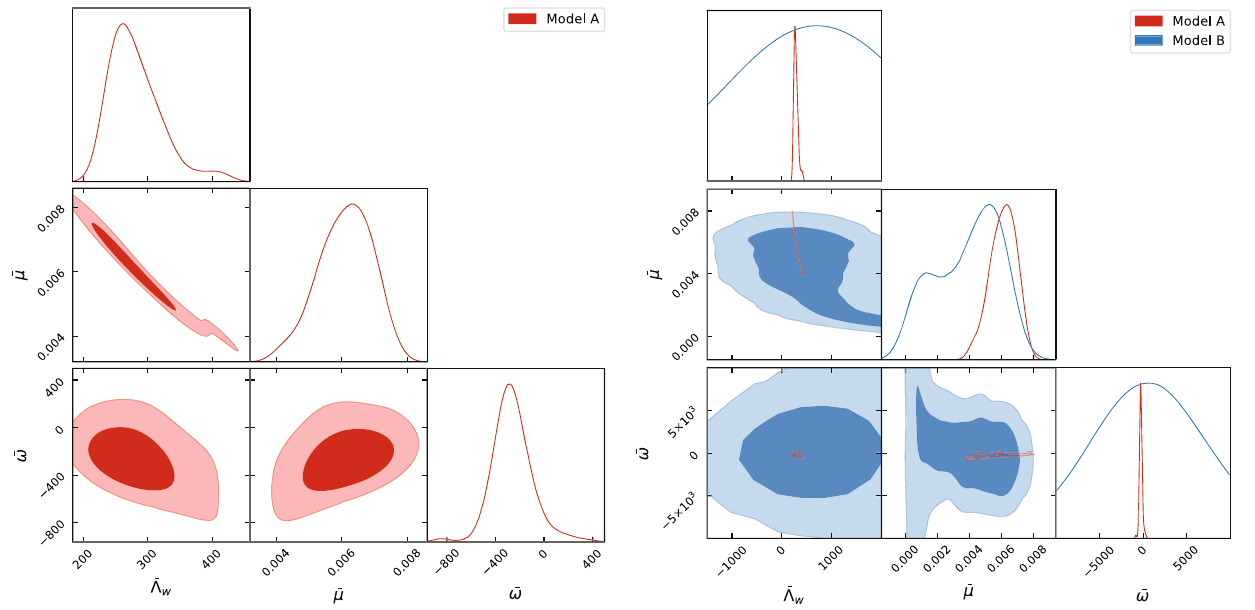
Fig. 6 2D joint and 1D marginalized posterior probability distributions for the theory parameters in Table 2, obtained within the models A (left), B (right), up to 2 σ